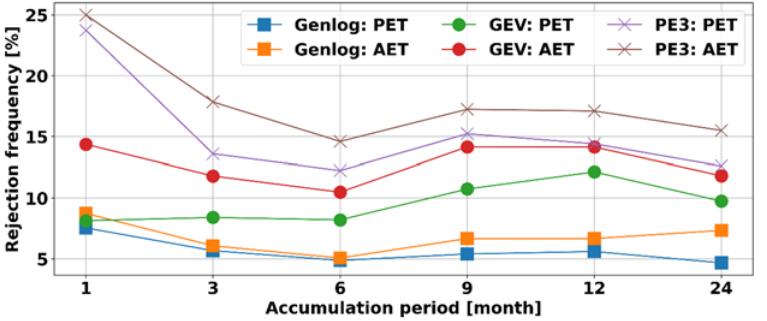
Figure 6. The AD goodness-of-fit test results for SPAEI (labeled orange, red, and brown lines) com ‐ pared to SPEI (labeled blue, green, and purple).